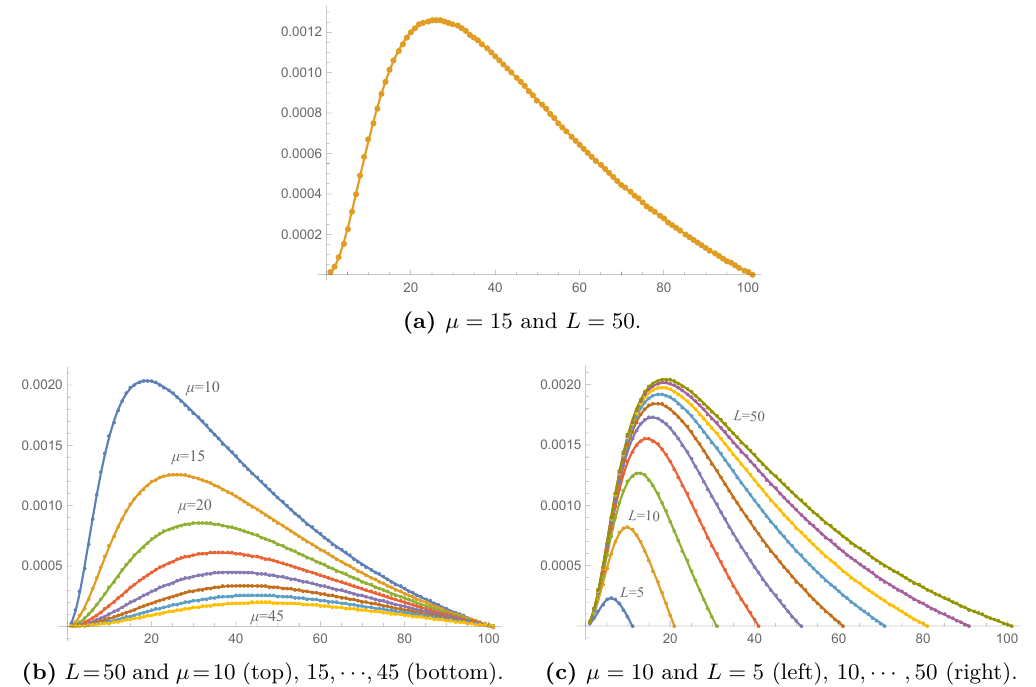
( x ) (up to − λ 2 ln λ 2 / 16 R 2 factor). The horizontal EE